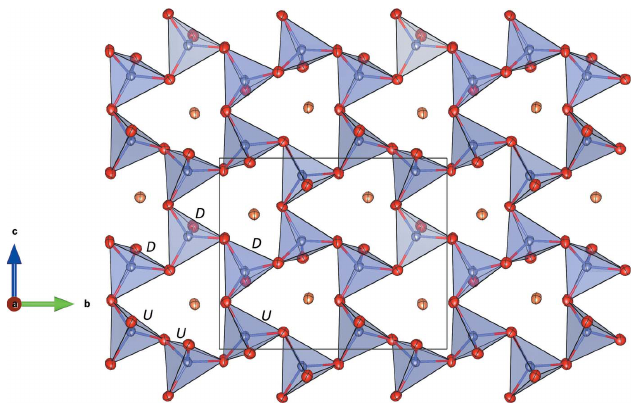
Figure 4 Single tetrahedral layer with six-membered rings in a projection along [100]. T -sites in the centres of the tetrahedra are shown in blue. Displacement ellipsoids are drawn at the 70% probability